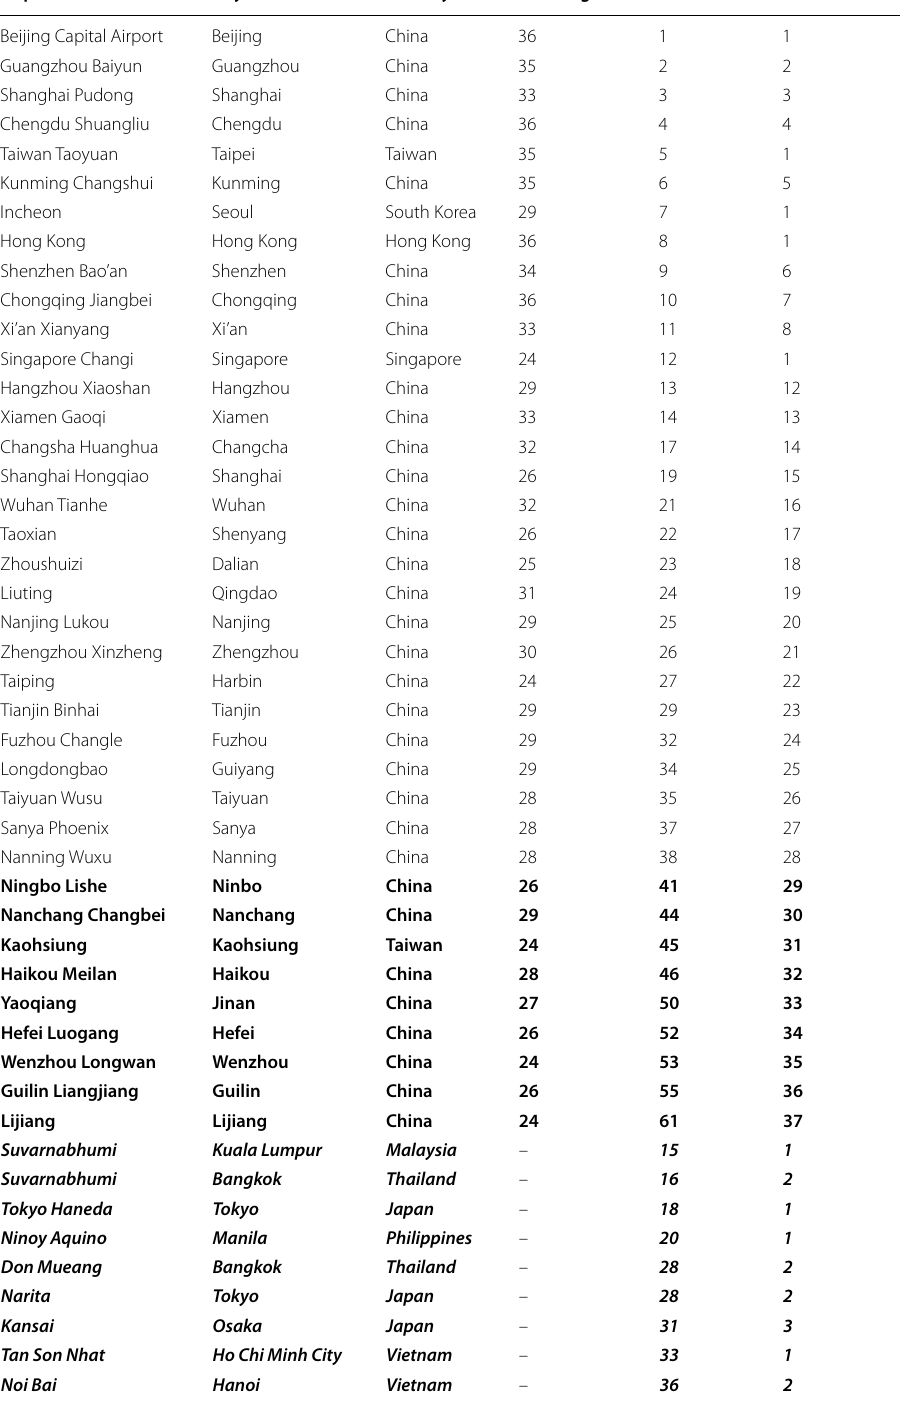
Airports not in the top 38 regional hubs are in bold. The core degree of a node is its number of links in the maximum k-core. Local rank is the rank in the large local component. National rank is the airport rank in its country. Airports in the top 38 regional hubs and not in the k-core are in